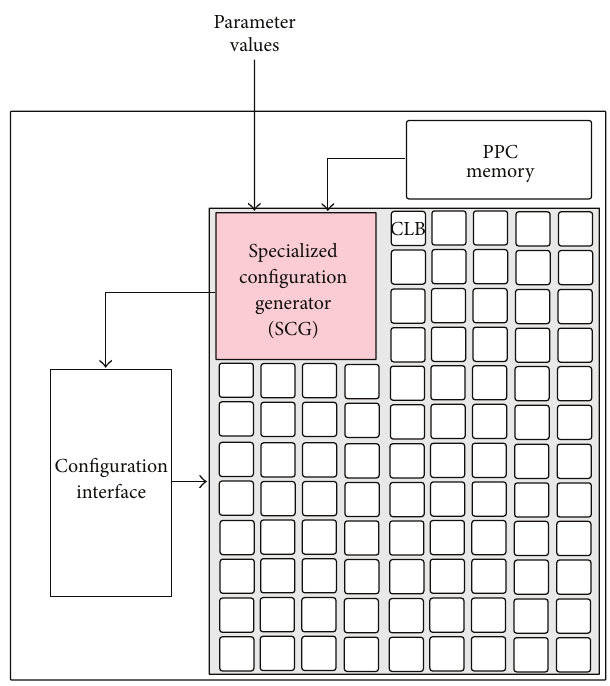
Figure 2: Dynamic Circuit Specialization on Xilinx